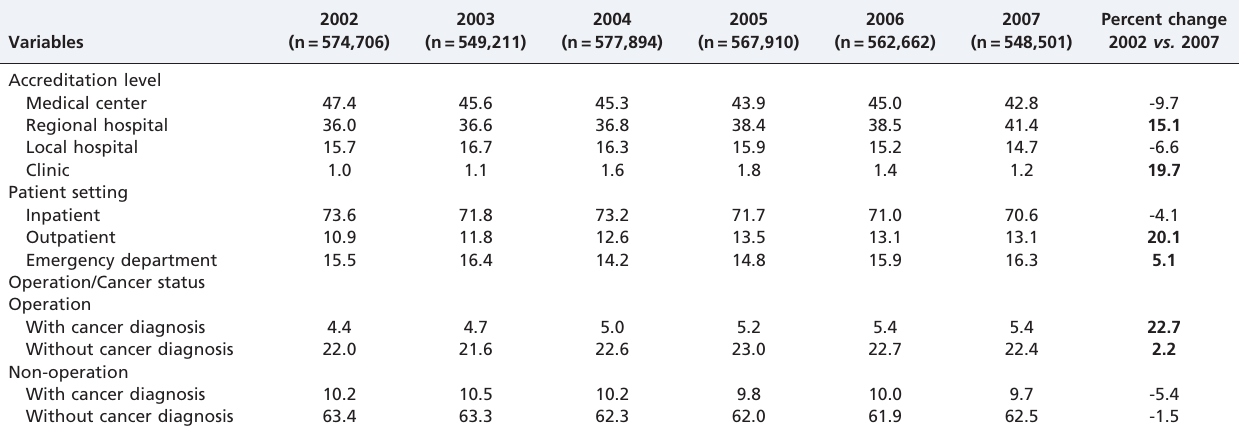
Table 3 - Proportion of total pethidine prescriptions according to health care characteristics, 2002-2007.